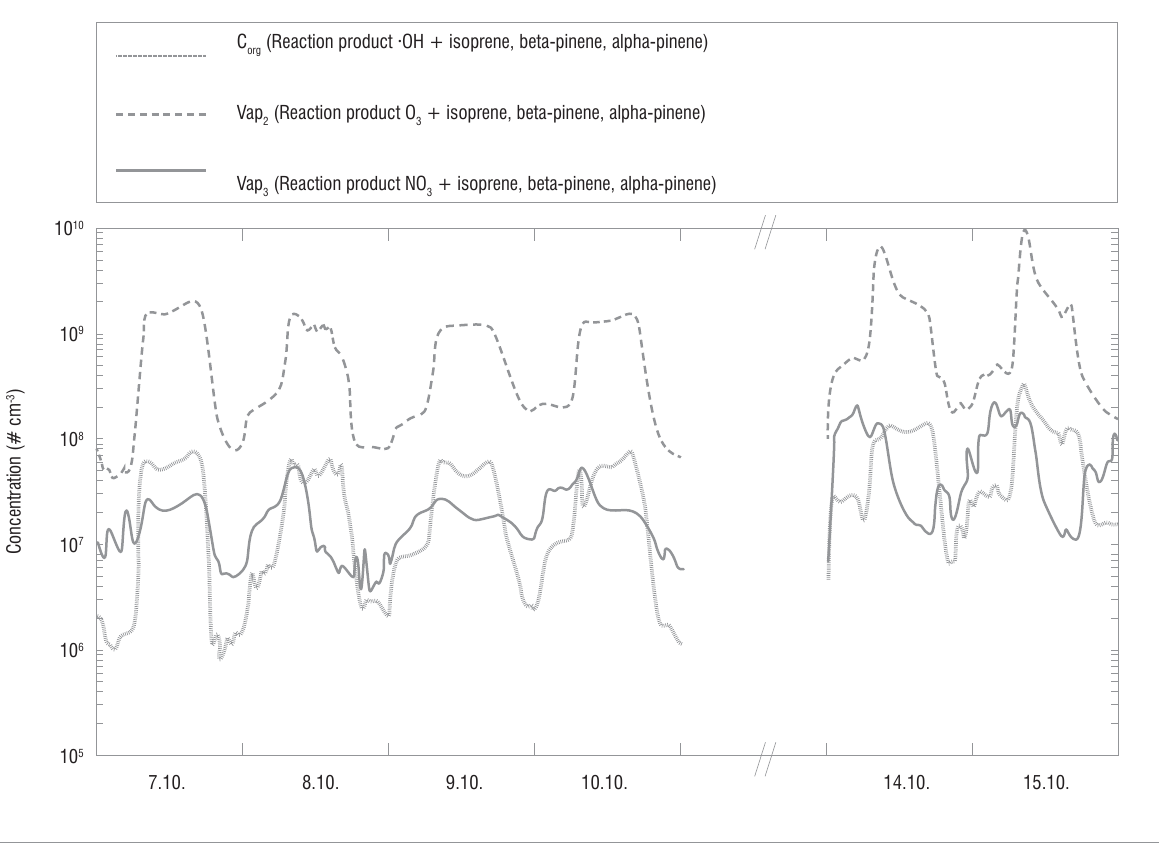
Figure 6: Modelled reaction products of volatile organic compounds (isoprene, α -pinene and β -pinene) with ·OH, O October 2007. The first mentioned participates in new particle formation, and all in particle growth in the